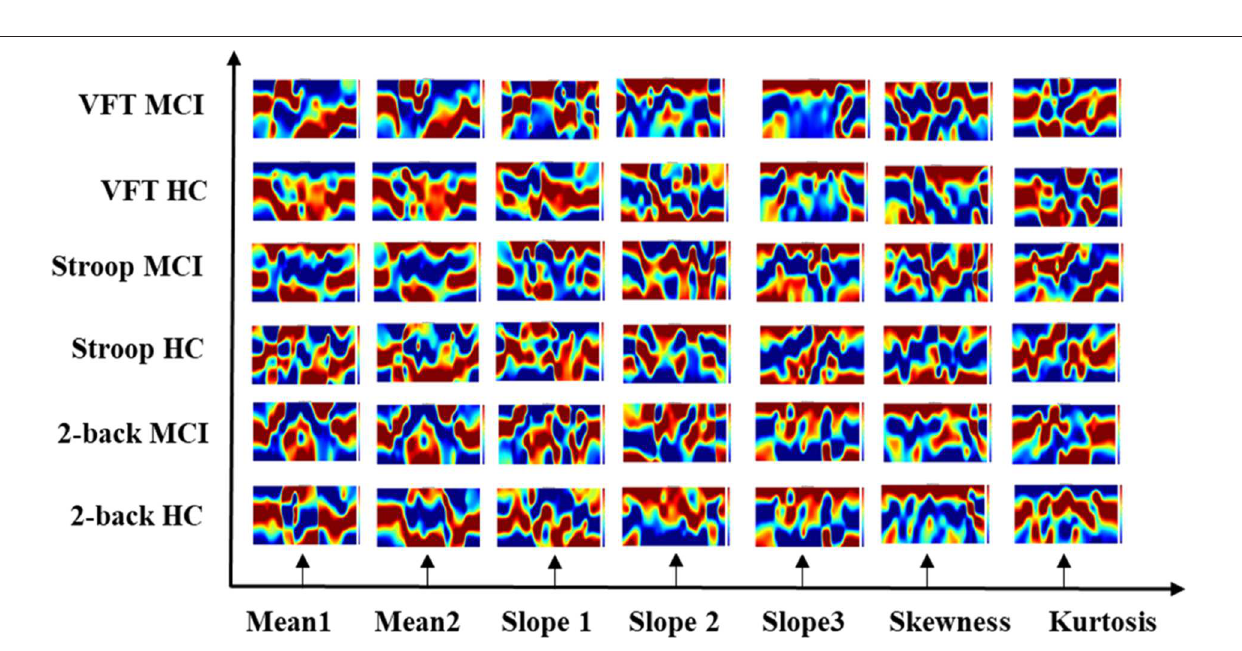
classified; TN is the number of HCs identified correctly; FP refers to the number misclassified as MCI patients, and FN is the number misclassified as